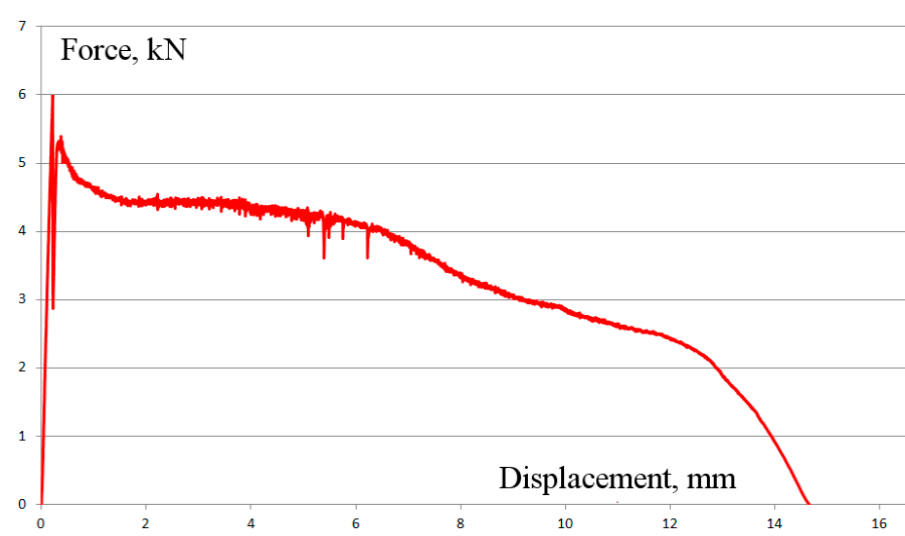
Figure 14. Force-displacement graph for J5 joint obtained during the test.